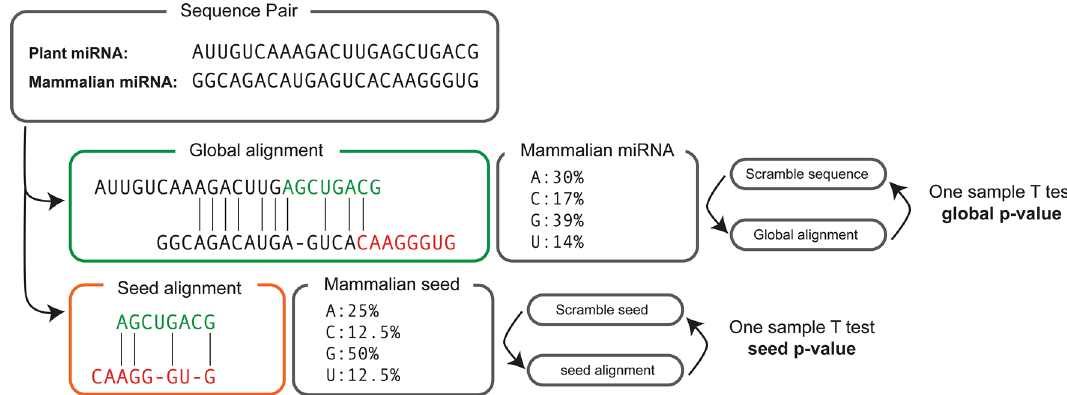
Figure 3. Inferring statistical significance for pairwise